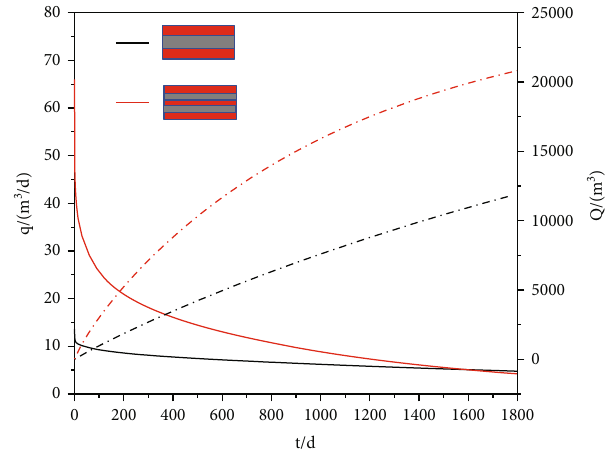
Figure 10: Daily production and accumulative production under di ff erent interlayer